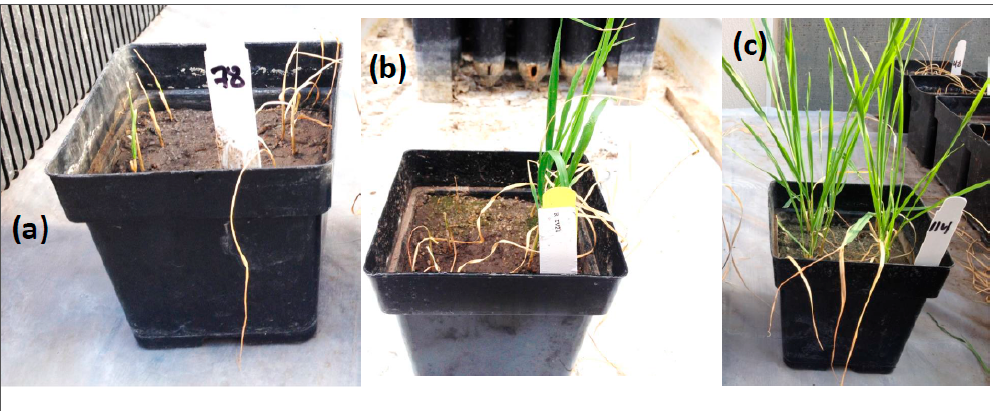
had green leaves and was fully wilted, and ( b ) a genotype had yellow leaves and no leaf wilting.